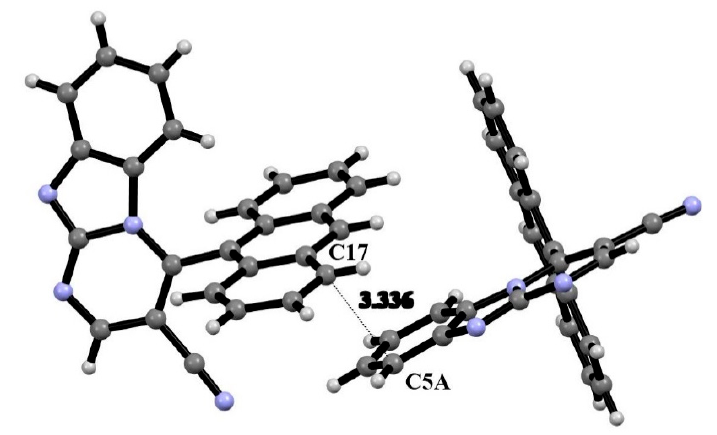
Figure 11. π - π -contacts in the crystal of the compound 6c .